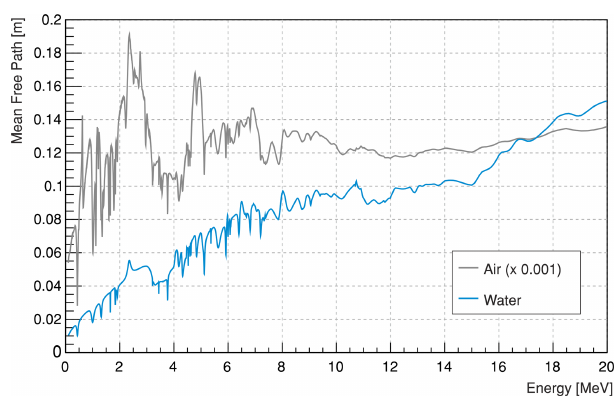
Figure 7. Mean free path 1 /(cid:54) t for neutrons in the MeV range. The dominant peaks originate from the contribution of the elastic scat- tering cross section in dry air (NTP) mainly by nitrogen and in water by oxygen; see also Fig.